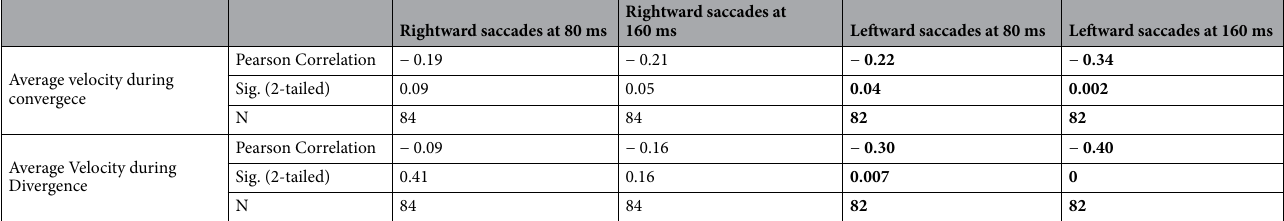
Table 3. Correlation between average velocity of convergence and divergence and speed of rightward and leftward saccades at 80 ms and 160 ms for all participants. Variables with significant differences between the two populations (p < 0.05) are bolded.